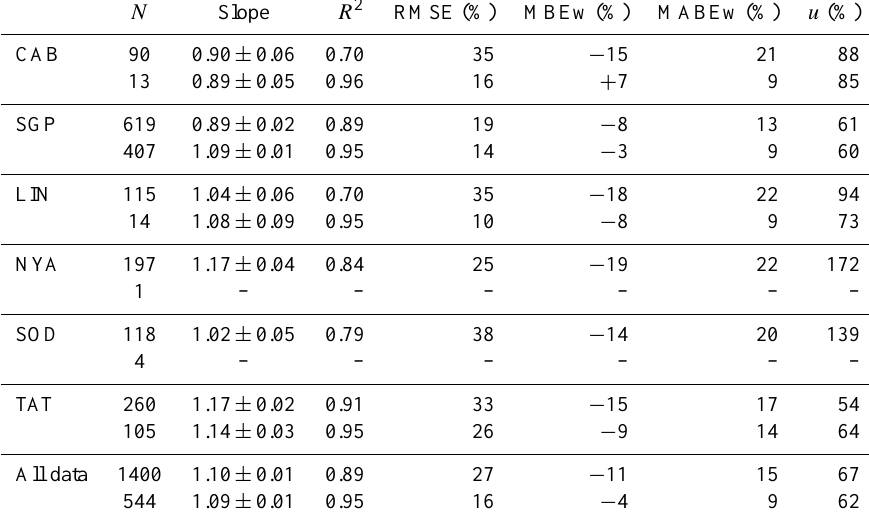
Table 2. Parameters obtained in the correlation analysis between GOME-2 TWVC data and GRUAN radiosonding measurements during the period 2009–2014. Upper (lower) rows show the parameters obtained for all-sky (cloud-free) conditions. The parameters are: N , number of data; Slope, slopes of regression lines; R 2 , determination coefficients; RMSE, root mean square errors; MBEw, weighted mean bias errors; MABEw, weighted mean absolute bias errors; u , uncertainty of MBEw and MABEw. N Slope R 2